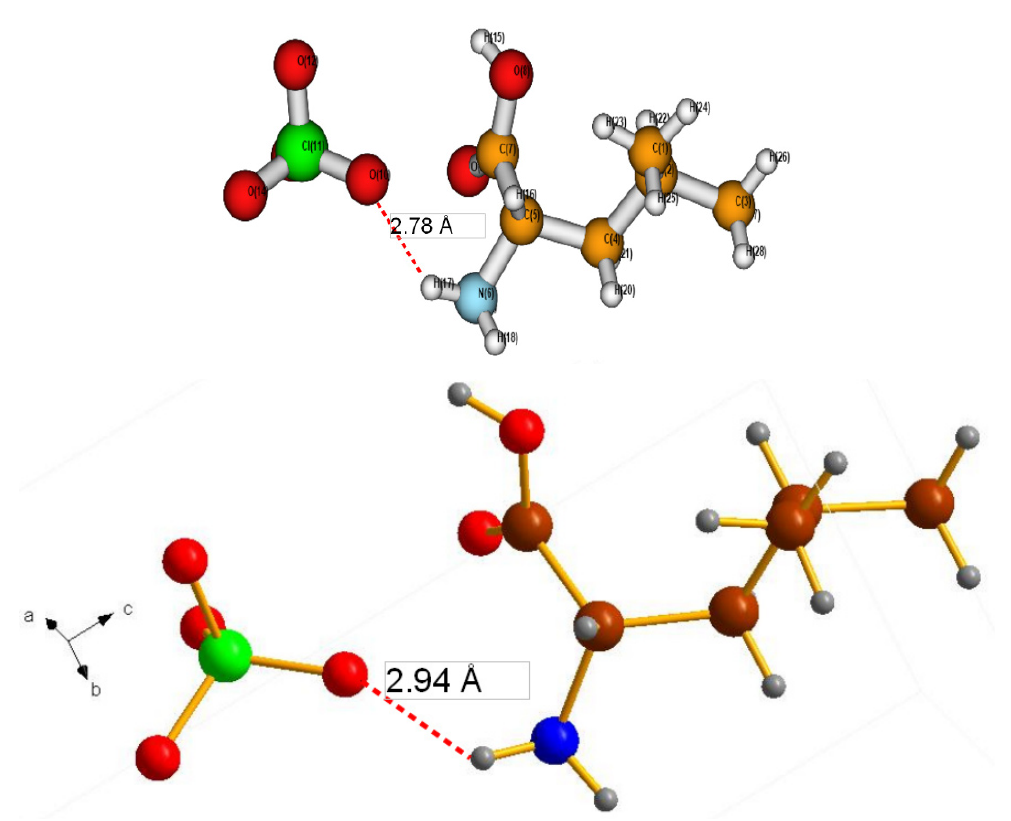
Figure 3. The equilibrium geometry of investigated